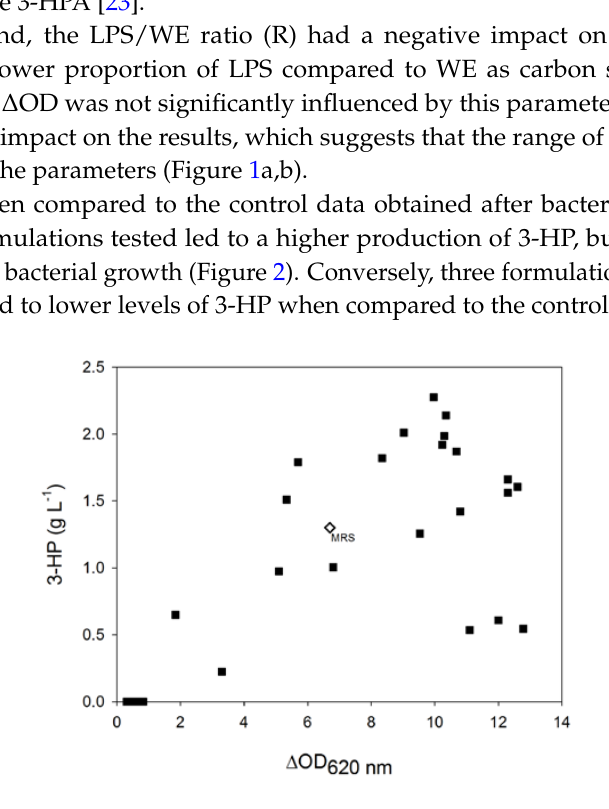
Figure 2. Concentration of 3-HP after the bioconversion phase as a function of the optical density at 620 nm measured at the end of the growth phase. Each point corresponds to a different formulation tested. Blank diamond: values obtained with MRS medium. Black squares: results obtained with the formulations of both design.